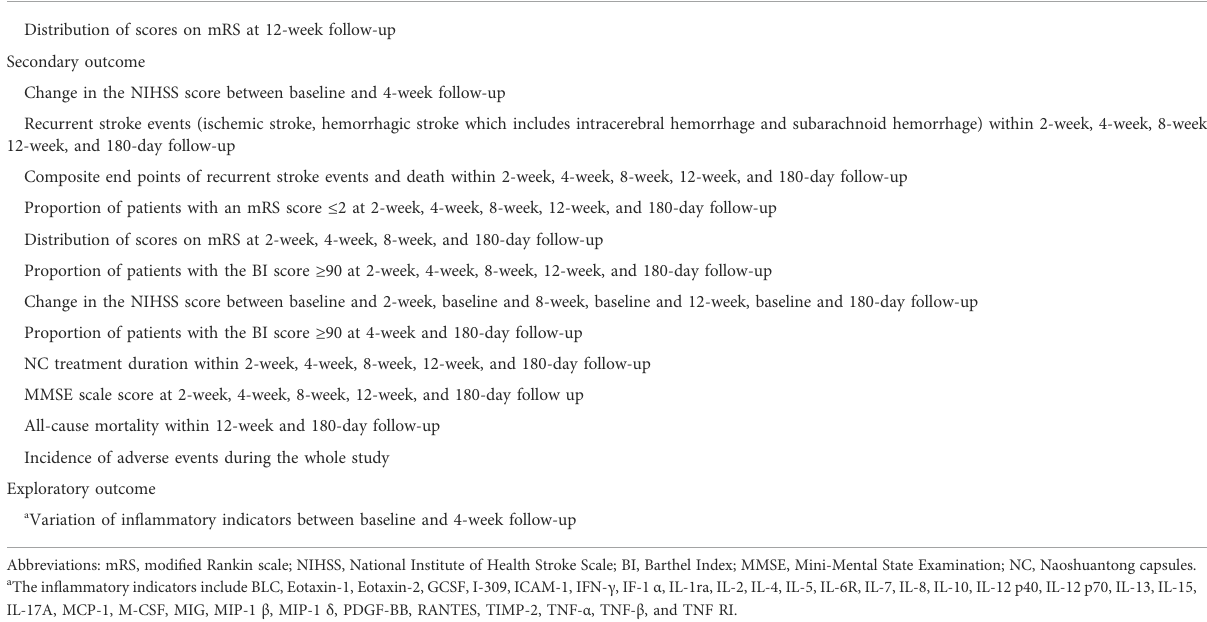
TABLE 1 Complete outcomes of the VENUS registry.